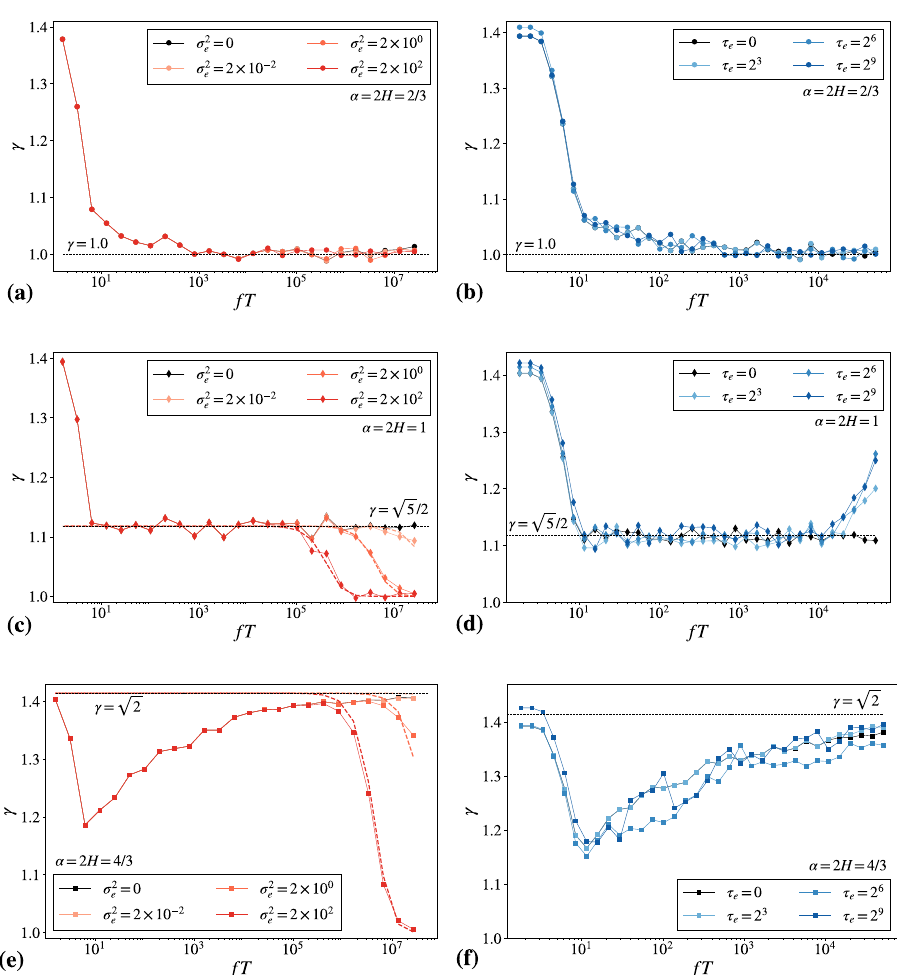
Fig. 1 One-dimensional fractional Brownian motion (FBM) trajectories. We show the coef fi cient of variation from Monte Carlo simulations of one- dimensional FBM trajectories in the presence of localisation noise. We set the generalised diffusion coef fi cient to D = 1 and the Hurst exponent to a and b H = 1/3 (subdiffusion), c and d H = 1/2(normal diffusion) and e and f H = 2/3 (superdiffusion). Panels a , c , and e : n = 10 4 realisations consisting of N = 2 23 discrete time steps with Δ t = 1 from the joint process de fi ned in Eq. (6), for static error only. The dashed lines represent the expected high- frequency asymptotic trend reported in Eqs. (11a) – (11c) for the different values of σ e and τ 0 = 1. Panels b , d , and f : n = 10 4 realisations consisting of N = 2 14 fi nal steps with Δ t = 1 obtained for pure FBM (black) and in the presence of dynamic error with τ e . The horizontal dashed lines represent the limiting value at high frequencies for pure FBM. Note that γ is reported as a function of fT , thus the limiting values obtained here for high-frequencies are also valid for the case of fi xed f and large T